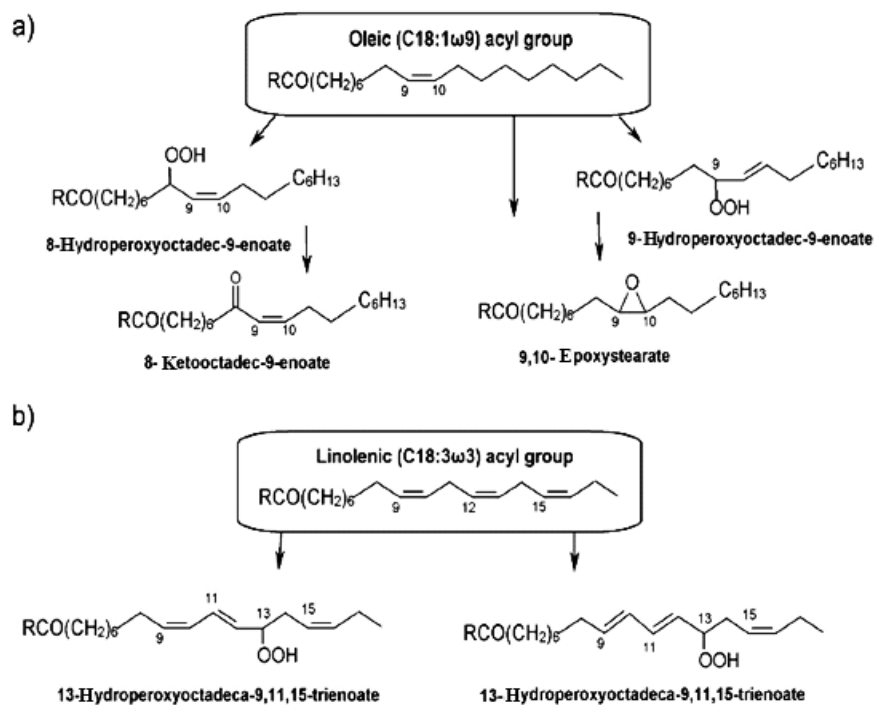
Figure 32. Some of the primary oxidation compounds derived from ( a ) oleic and ( b ) linolenic acyl groups, that can be detected by 1 H-NMR. Adopted, with permission, from [26]. Copyright 2014, Institute of Food Technologists.